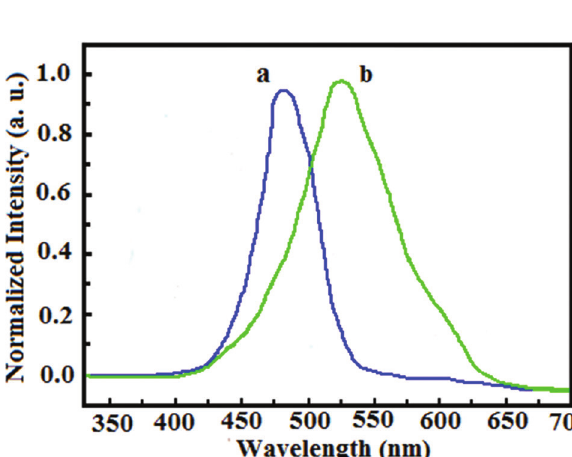
Figure 7: Fluorescence spectra of tin complex in solid state ( b ) and methanol (ca. 1×10 –5 M) ( a